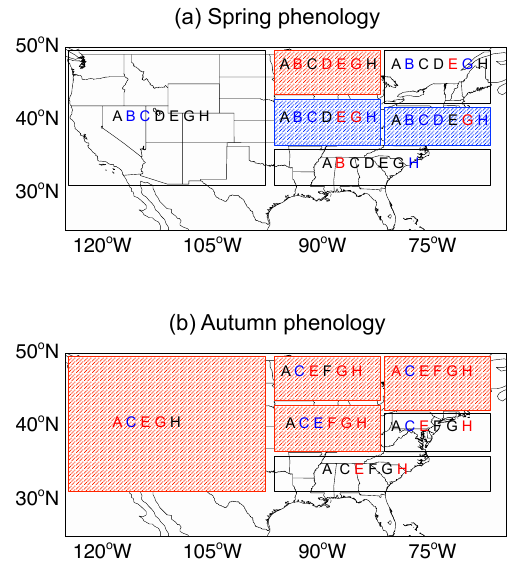
(b) Autumn phenology Figure 7. Comparison of phenology trend over the USA for (a) spring and (b) autumn estimated by different studies. The US domain is divided into six patches to represent different geographic areas: west, north, northeast, center, east, and southeast. In each patch, different characters represent estimates from different studies over that area. A summary of all studies used for comparison is listed in Table 1. The color of a character indicate the sign of a trend as follows: red is positive, blue is negative, and black is zero or insignificant. A patch is hatched with the same color as the dominant trend if it is non- zero.